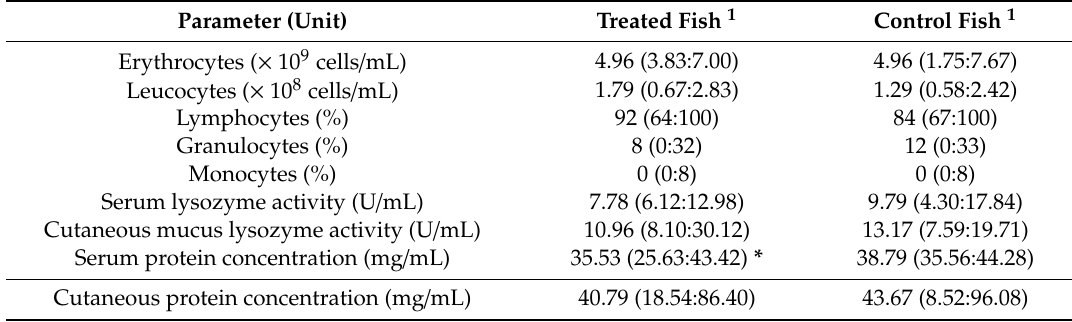
Table 1. Parameters of the innate immune response in rainbow trout when Pseudomonas fluorescens LE89 is administered to the water.